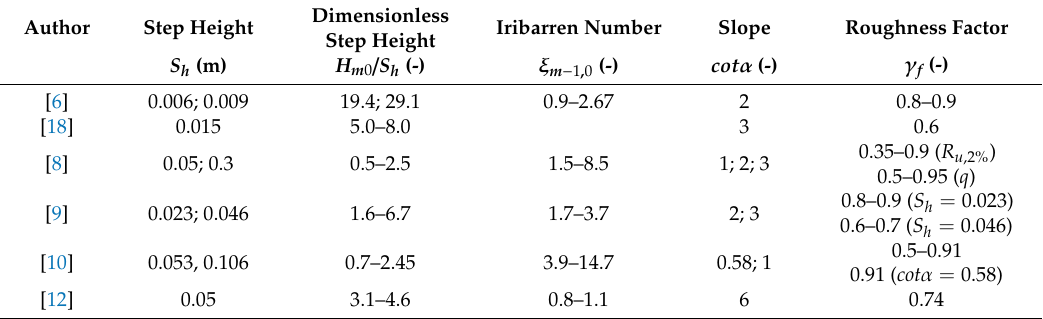
Table 1. Influence factors for roughness for plain stepped revetments by various